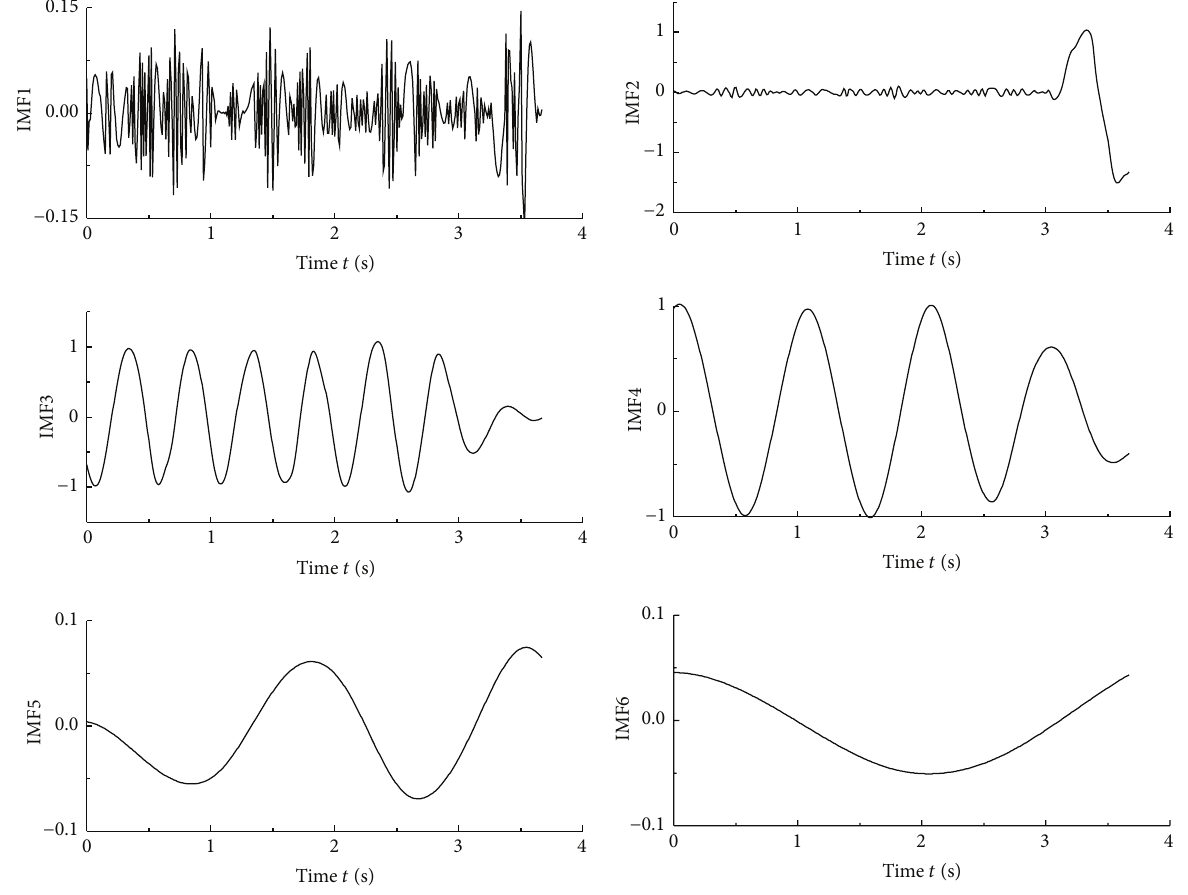
Figure 5: EMD decomposition results of the filtered